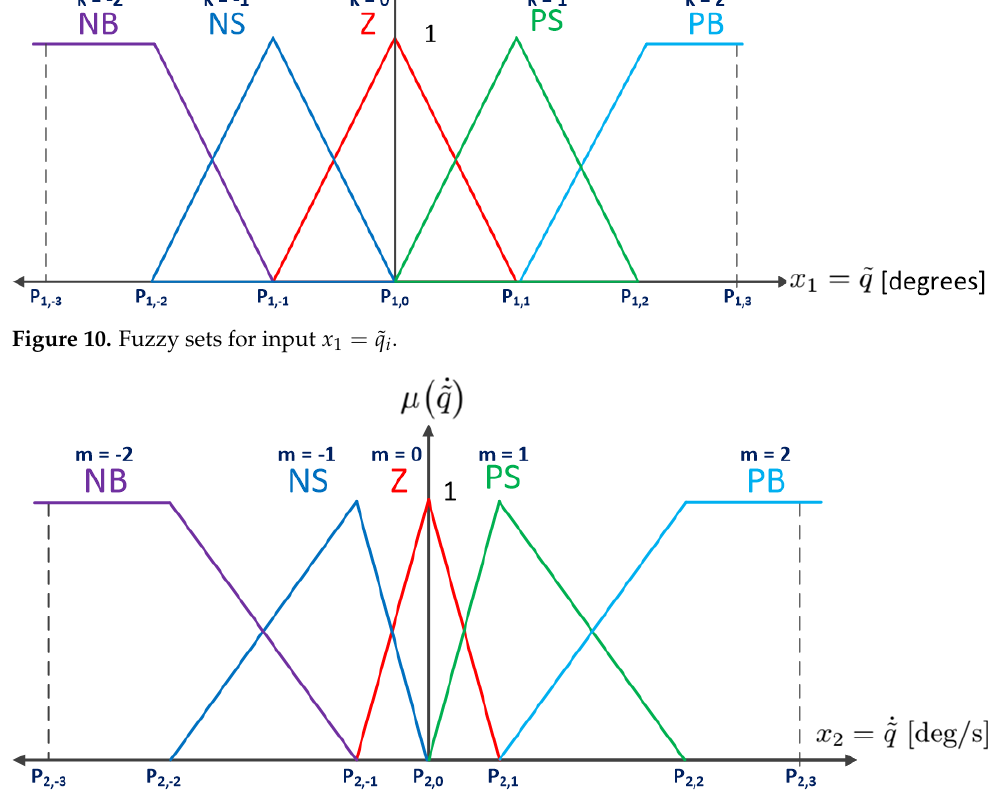
Figure 11. Fuzzy sets for input x 2 = ˙˜ q i